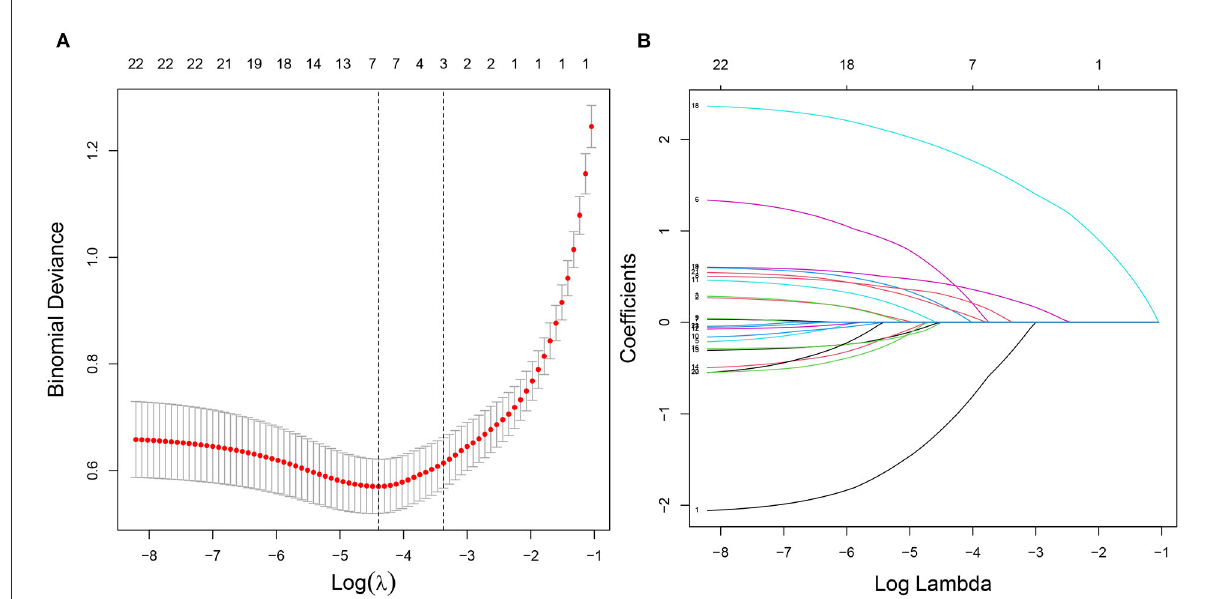
FIGURE2 Characteristic variables were screened using LASSO regression analysis. (A) The selection of the best parameter (lambda) in the LASSO model uses 10-fold cross-validation with the lowest standard. The relationship curve between partial likelihood deviation (binomial deviation) and log (lambda) was plotted. Dotted vertical lines were drawn at the optimal values by using the minimum criteria and the one SE of the minimum criteria (the one SE criteria). (B) LASSO coefficient profiles of the seven characteristic variables. A coefficient profile plot was produced against the log (lambda) sequence. LASSO, least absolute shrinkage and selection operator; SE, standard error.